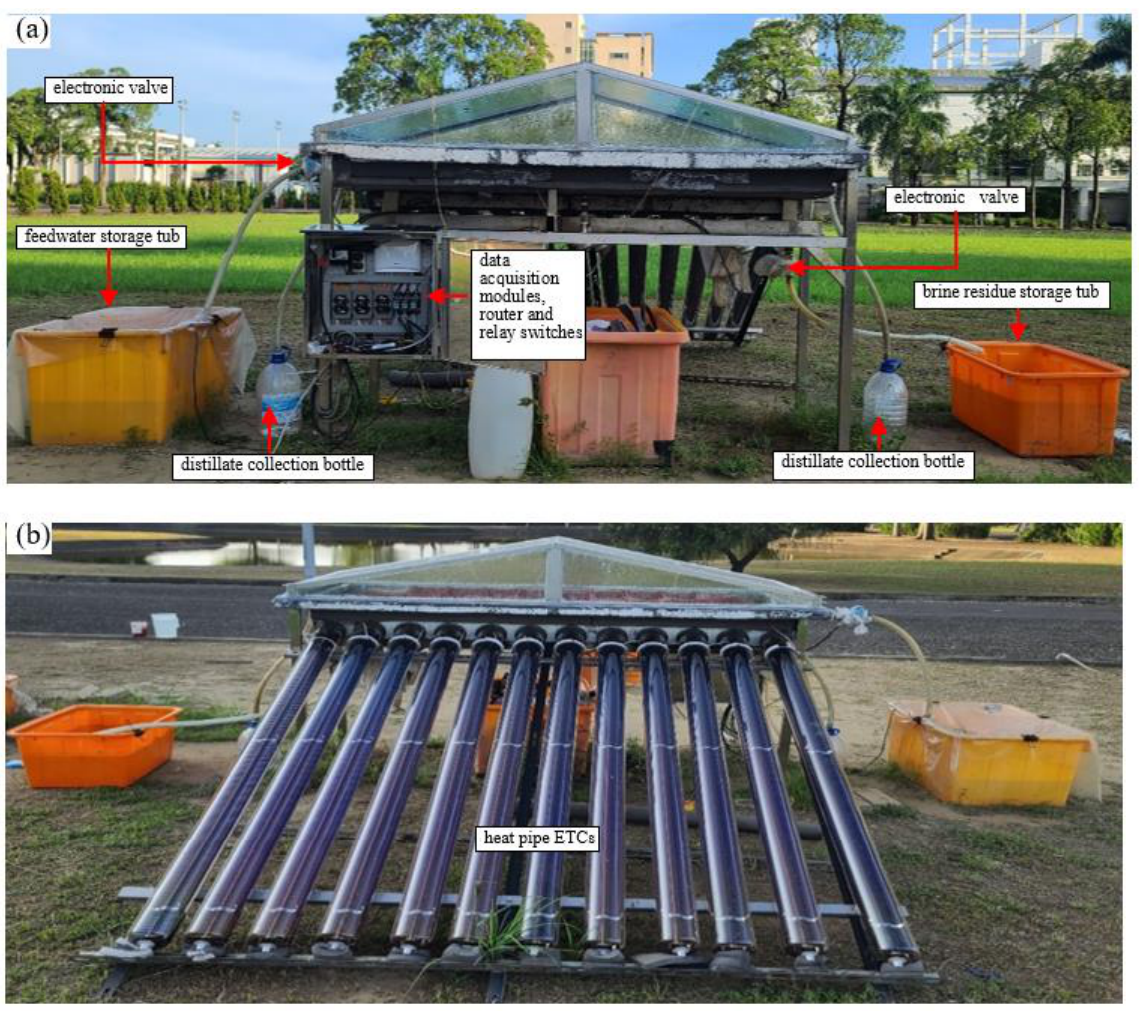
Figure 1. Experimental setup of the solar still installed in a north-south orientation: ( a ) northern side, ( b ) southern side.